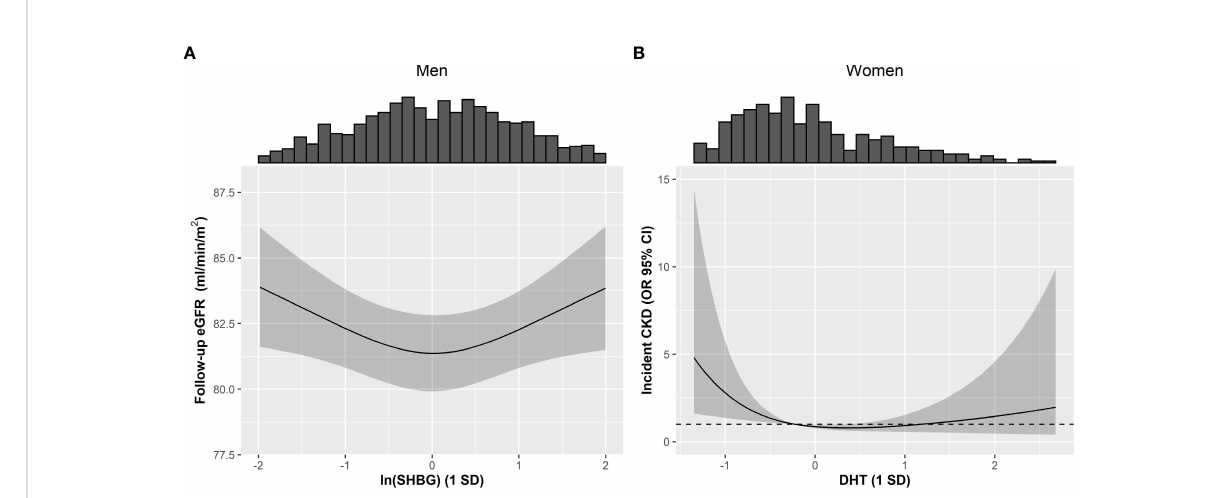
FIGURE 2 Restricted cubic splines describing non-linear associations between androgens or SHBG with kidney function in men and women of the KORA F4/ FF4 study. Non-linear associations between (A) ln(SHBG) and follow-up eGFR in men, plus (B) between DHT and incident CKD in women. Non- linearity was investigated by introducing a quadratic term to the models for all exposures. Interaction between diabetes and DHT or SHBG was assessed using a 3-way interaction (i.e. DHT or SHBG*diabetes + (DHT or SHBG) 2 *diabetes). Non-linear associations were not modi fi ed by diabetes (P interaction : (A) 0.920 and (B) 0.948). Solid line represents the estimated spline function for follow-up eGFR and incident CKD, and the grey shaded area represents the respective 95% CI spline estimation. The histograms provide insight to the population density along ln(SHBG) and DHT values. Models were adjusted using Model 2, comprising of baseline eGFR, baseline age, waist circumference, systolic blood pressure, usage of antihypertensive medication, non-HDL cholesterol, prevalent cardiovascular disease, usage of lipid-lowering medication, smoking status, physical activity, alcohol consumption, diabetes status, and ln(CRP). CKD: Chronic kidney disease, CI: Con fi dence interval, CRP: C-reactive protein, DHT: Dihydrotestosterone, eGFR: Estimated glomerular fi ltration rate, HDL: High-density lipoprotein, OR: Odds ratio, SD: Standard